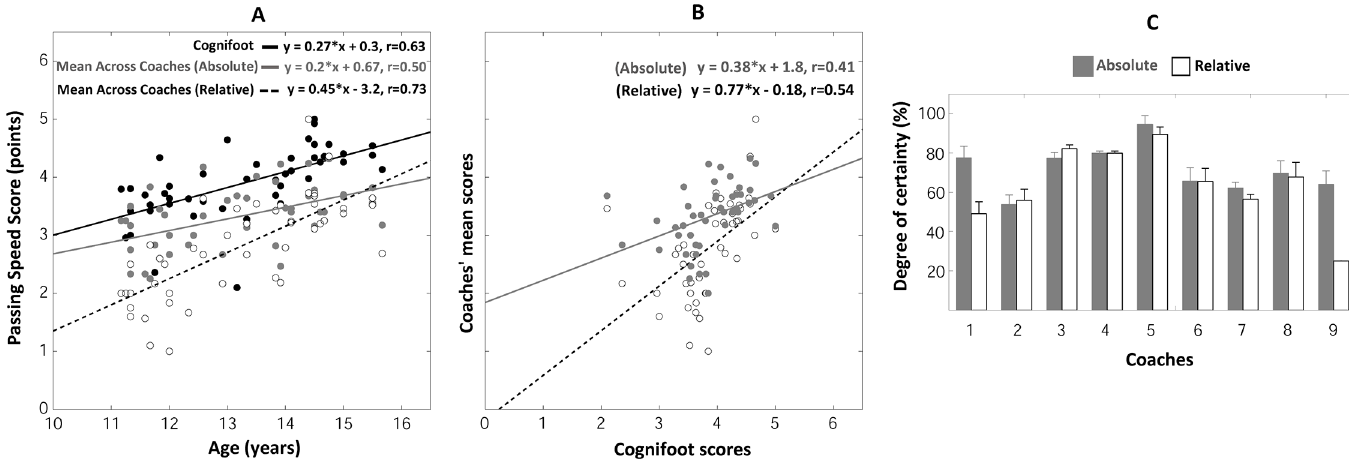
Fig 6. Passing speed scores as a function of age, measured by the Cognifootsystem or judgedby coaches (A)—Cognifoot scores vs mean coaches’ scores (B) Degreesof certainty of the coaches in their -passingaccuracy- judgments (C).